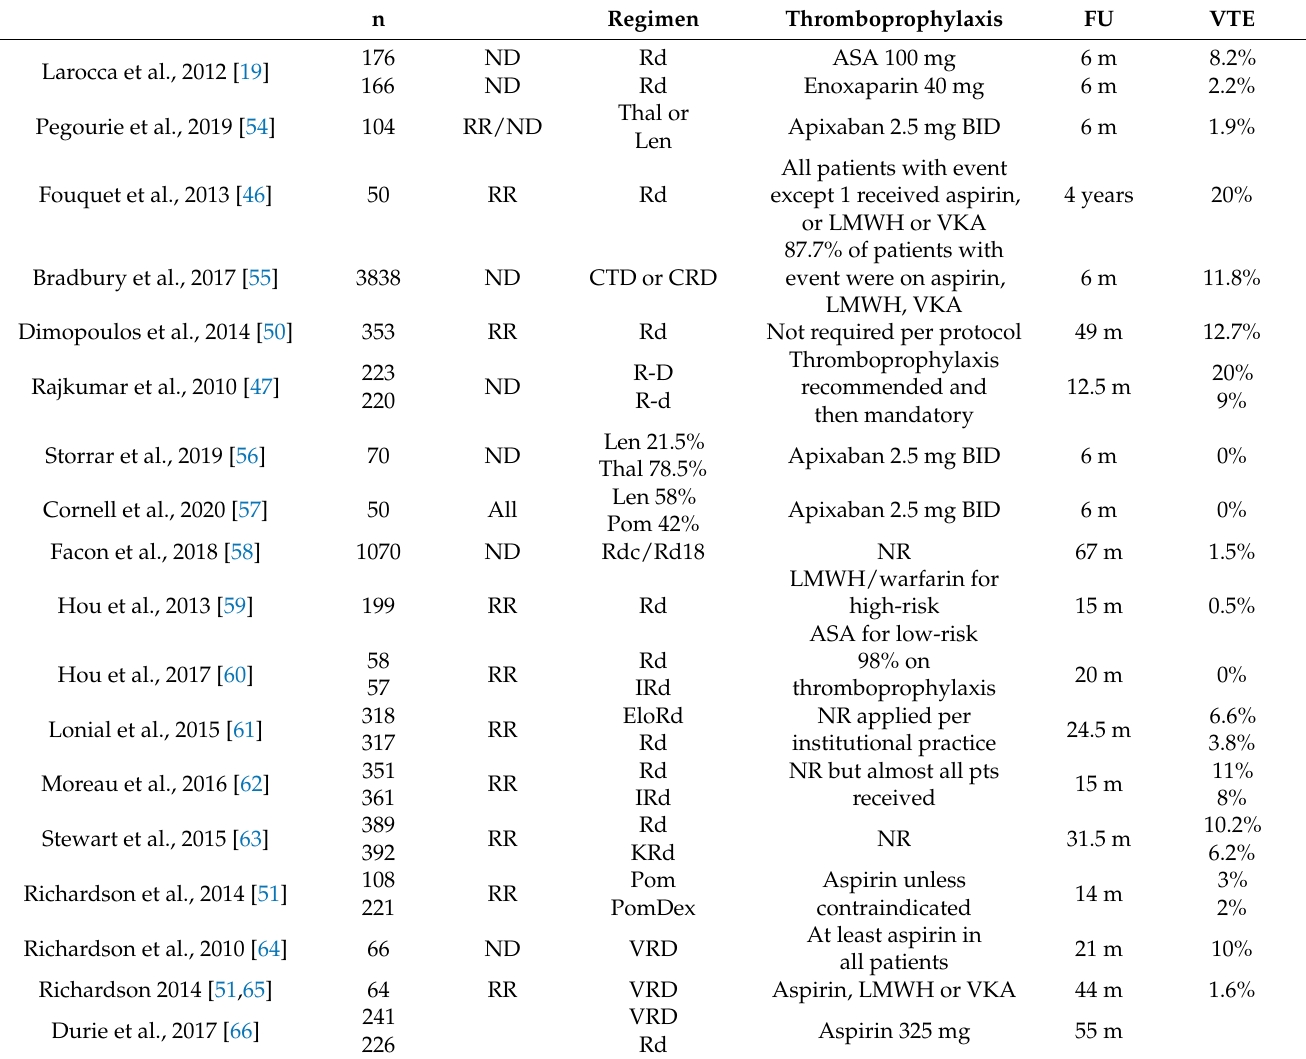
Table 1. Main clinical trial data regarding immunomodulatory agent (IMiD)-based regimens in the new treatment